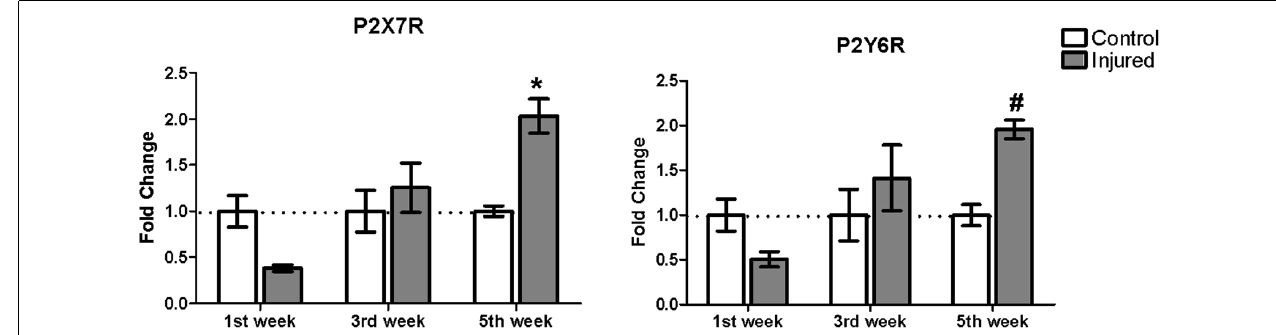
FIGURE 2 | Gene expression of P2X7 and P2Y6 receptor subtypes in the striatum of rats following 1, 3 and 5 weeks after injury with 6-OHDA. Gene expression levels of the purinergic receptors curve in control and 6-OHDA-injured (7 µ g/kg) hemispheres. ∗ p < 0.05, in relation to respective control hemisphere. F ( 2,12 ) = 10.6406, p = 0.002. # p < 0.05, in relation to the injured hemisphere from the first week post injury, F ( 2,12 ) = 5.6969, p = 0.018. n = 3 for each group. Two-way analysis of variance (ANOVA) followed by Bonferroni post hoc tests was used for statistical